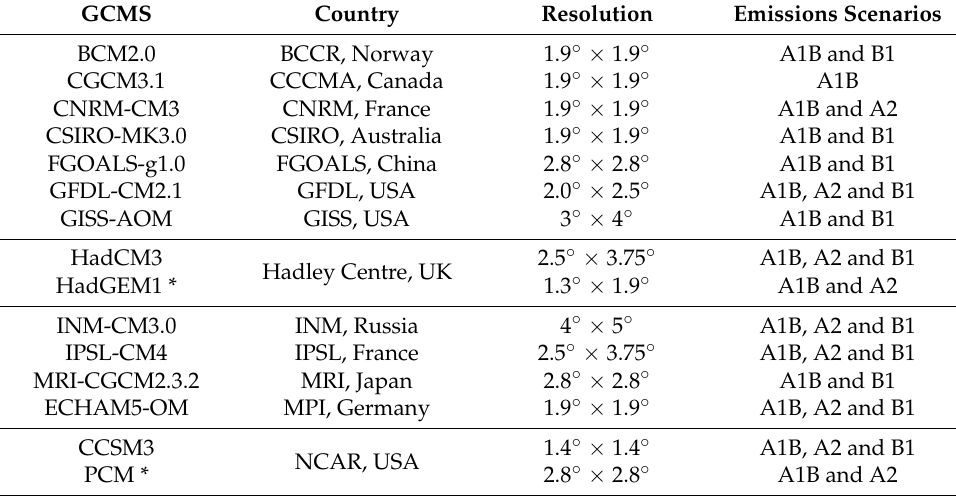
Table 1. Summary of selected General Circulation Models used in this